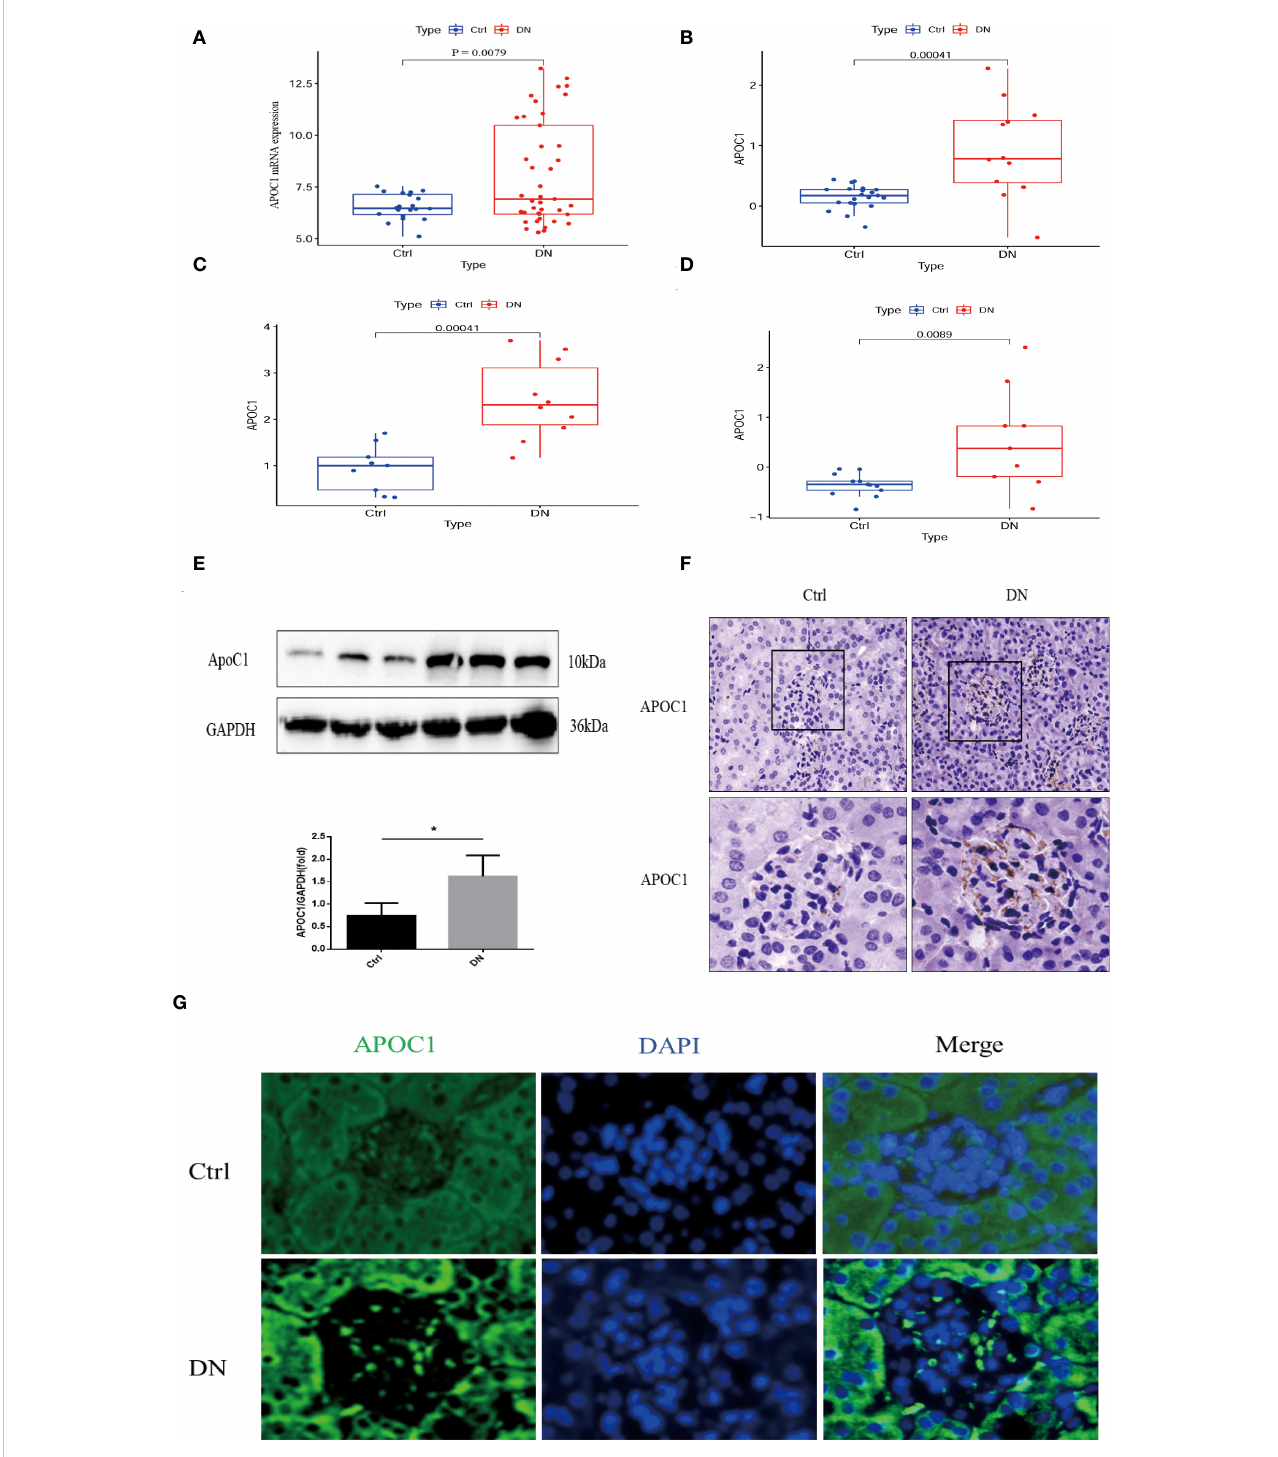
FIGURE 6 Exhibition of the expression of APOC1 in DN. (A – D) APOC1 manifested signi fi cantly higher expression in different cohorts of DN patients. [ (A) : GSE96804, Ctrl=20, DN=41, (B) GSE47185, Ctrl=21, DN=12, (C) ERCB Nephrotic Syndrome Tublnt cohorts in Nephroseq database, Ctrl=9, DN=10, GSE 30122, Ctrl=13, DN=9]. (E) Representative Western Blot indicates APOC1 expression to be higher in different mice, Ctrl (n = 4) or DN (n = 4). (F) IHC reveals increased expression of APOC1 on glomeruli of mice with DN (Bar = 20 m m). (G) Representative protein immuno fl uorescence of APOC1 in the glomeruli of DN (Bar = 20 m m.). (Data presented as mean ± SEM, *P <